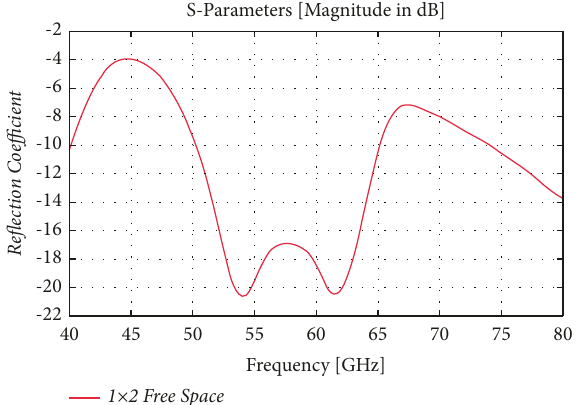
Figure 11: Return loss of the 1 × 2 antenna array.